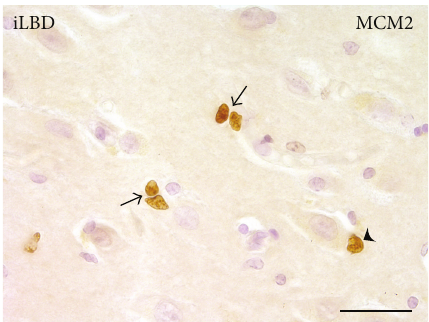
Figure2:MCM2-positivecellsinthehippocampalCA3regionofan iLBD case. High magnification of MCM2 IR reveals clear examples of doublets (arrows). The MCM2-positive cell indicated with the arrowhead is closely opposed to a large pyramidal neuron; bar = 25 𝜇